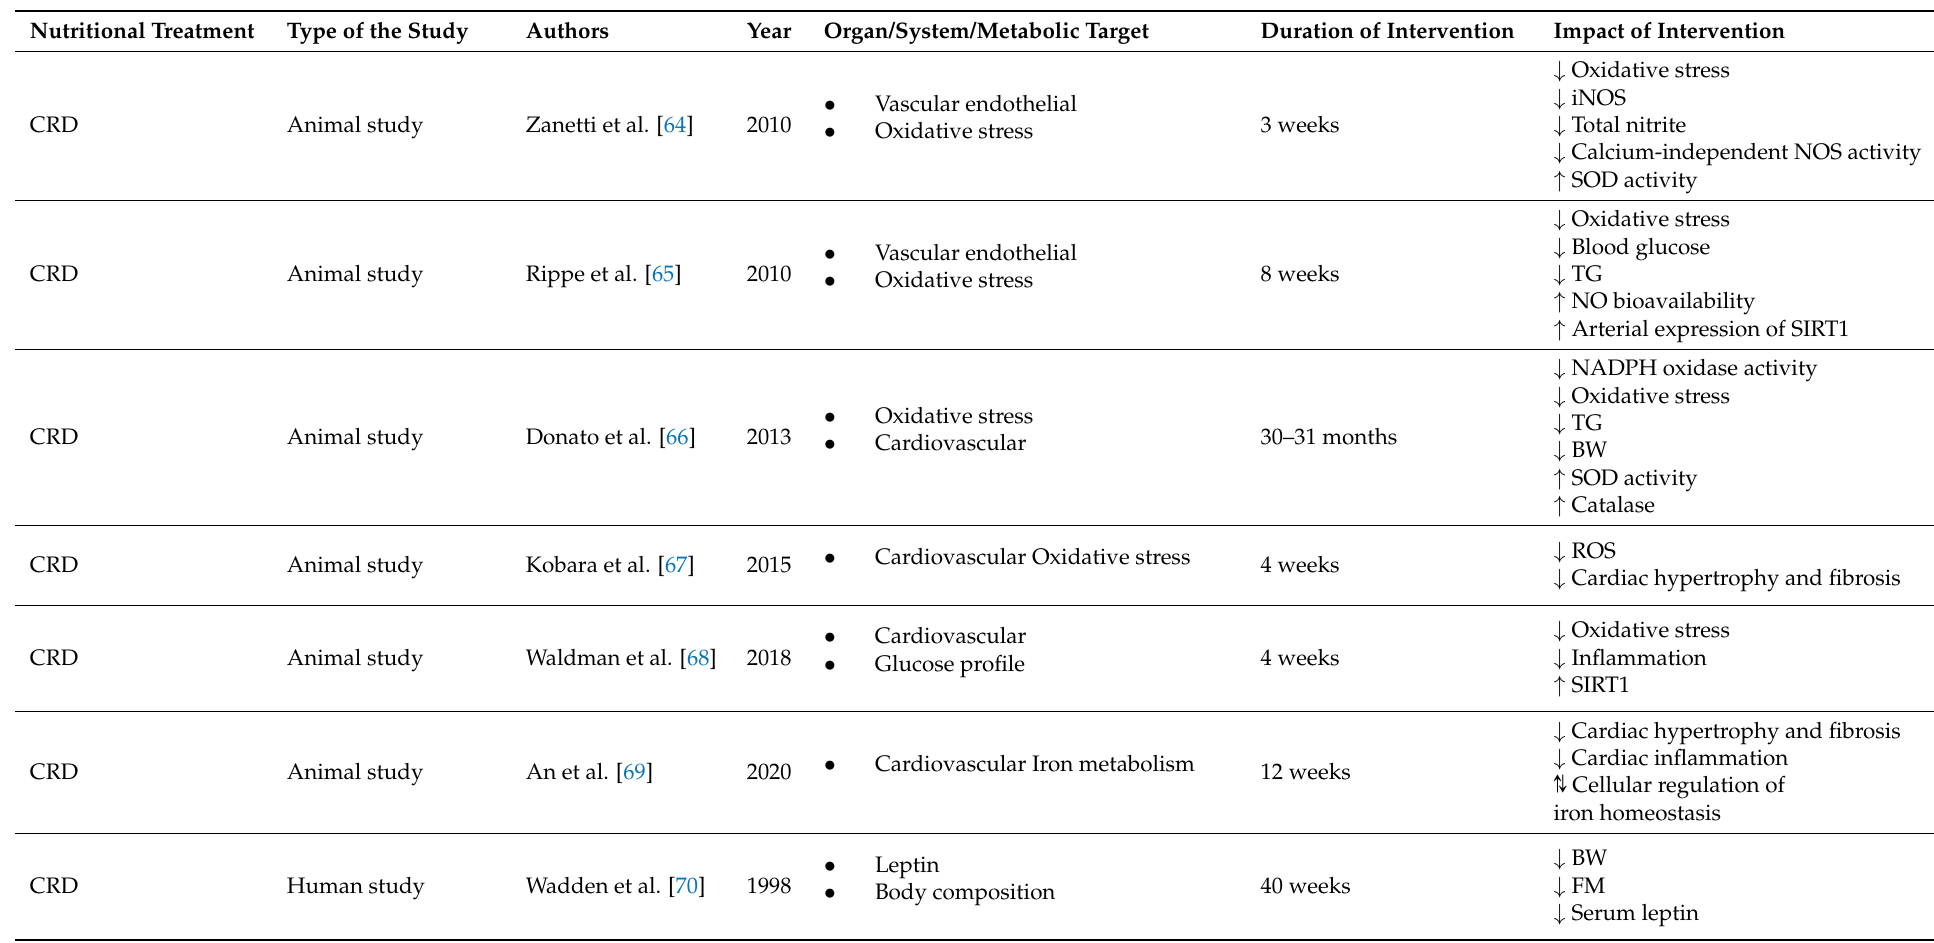
Table 1. Dietary approaches in the arterial hypertension